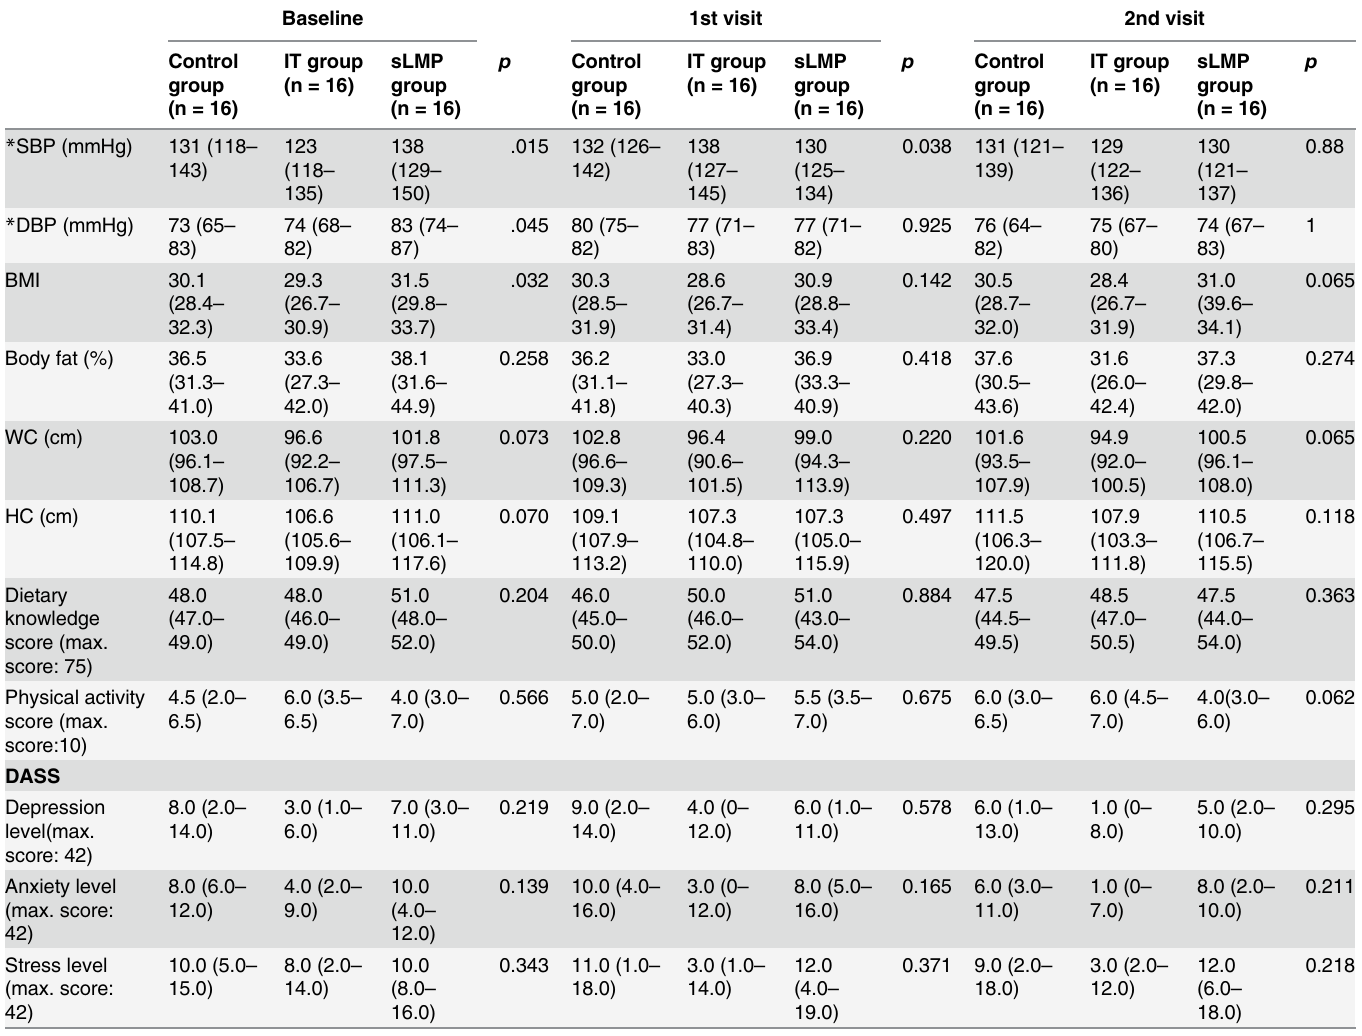
Table 4. Comparison of anthropometric measures, dietary knowledge score, physical activity score and Depression, Anxiety and Stress Scale (DASS) score between the control, internet (IT) and simplified lifestyle modification programme (sLMP) groups at baseline, 1 st visit (week 12) and final visit (week